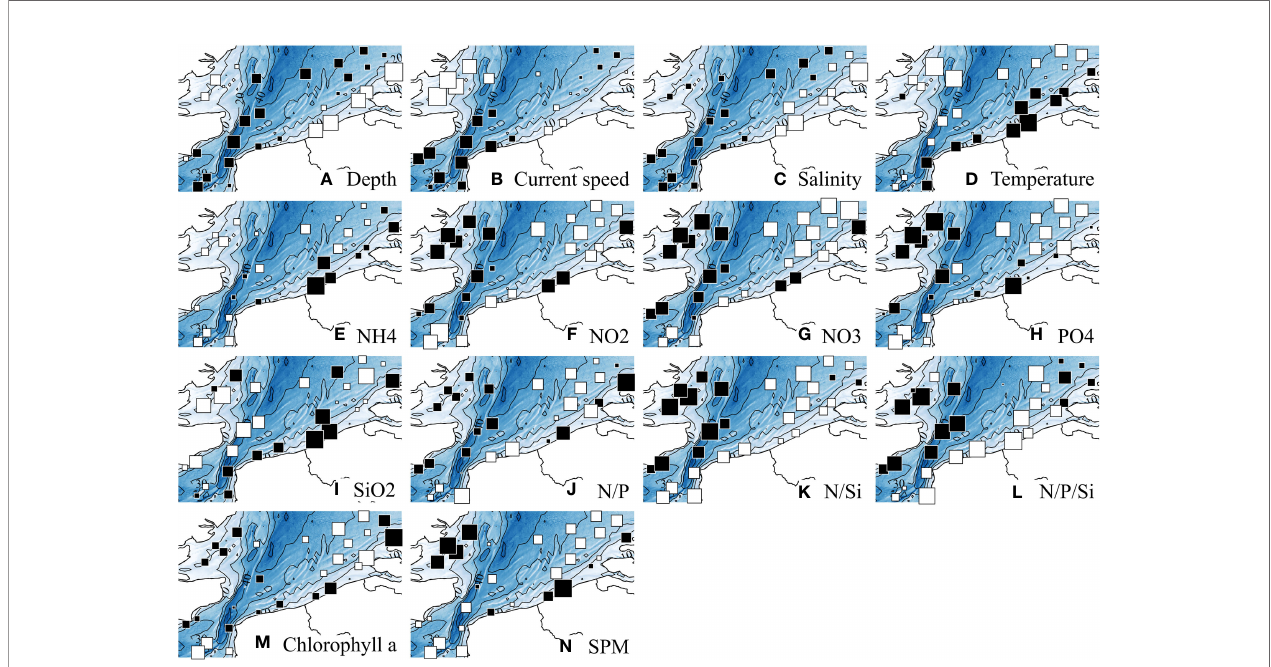
FIGURE 2 | Spatial distributions of abiotic descriptors. Chlorophyll a is also displayed as it is a core parameter measured in oceanographic studies. Values, after ln - transformation, were standardized with mean = 0 and SD = 1. White and black squares, values respectively lower and greater than the mean; square size is proportional to the deviation from the mean. Statistical details of each descriptor are provided in Table 3